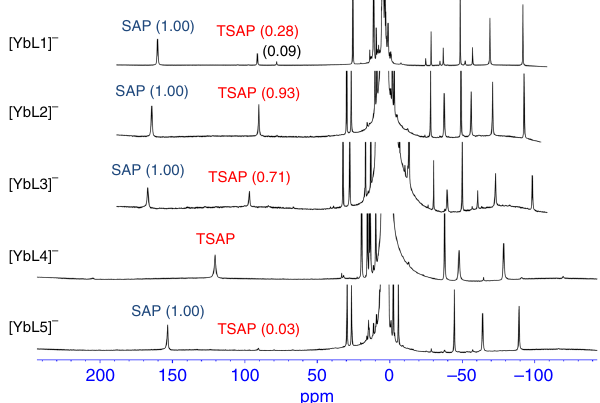
Fig. 4 1 H NMR spectra of Yb complexes. 1 H NMR spectra of [YbL1] − to [YbL5] − . The spectra gave ligand-dependent TSAP/SAP isomer ratios when Yb(III) is complexed with different ligands; attributed to the different substituents on the macrocyclic ring. The integrations of both isomer peaks are listed in parentheses with the integration of SAP isomer set as 1 [YbL3] − is similar to [YbL2] − and those for [YbL4] − and [YbL5] − are consistent with their europium analogues. The difference in chemical shifts for complexes of L4 is attributed to the aromatic nature of the benzyl substituent compared to the alkyl nature of the other compounds. When the complexation conditions of [EuL2] and [YbL2] were used for [GdL2] − , the ratio of TSAP/SAP of [GdL2] − was ~1:1 in the RP-HPLC trace, and the isolated yields for these two isomers were 46% ( fi rst peak, SAP) and 48% (second peak, TSAP), respectively. It is important to note that if the pH was adjusted to